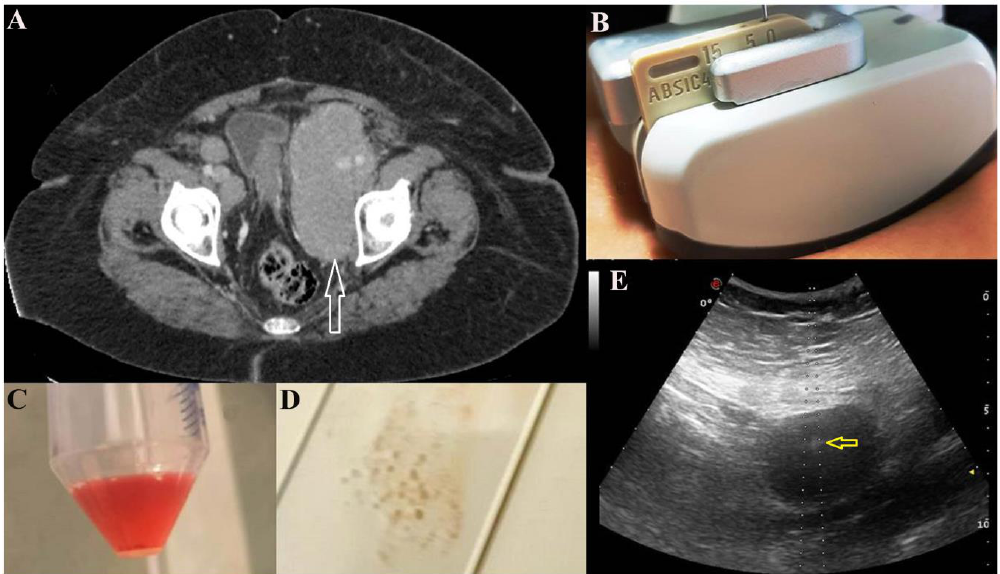
Figure 1. Computed tomography (CT) scan: solid abdominal/retroperitoneal pelvic mass (white arrow) ( A ). US-FNA: a dedicated probe with a central hole through which the needle set is introduced (at angle: 0°) ( B ). Cytological sample aspirated for CB ( C ) and smear for conventional cytology (CC) ( D ). Needle (yellow arrow) within the mass ( E ).